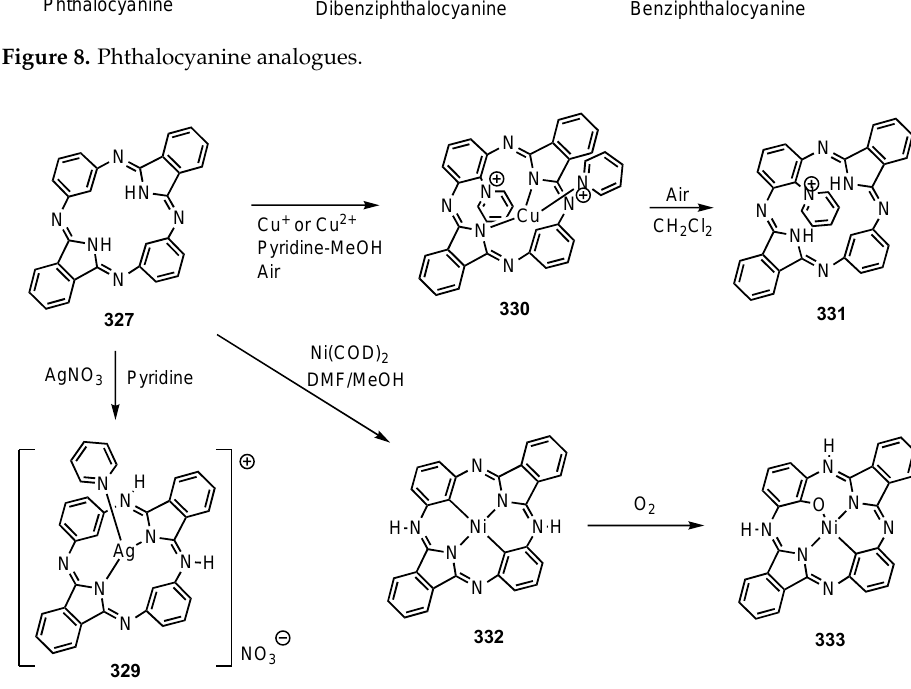
Scheme 53. Metal complexes of dibenziphthalocyanine.